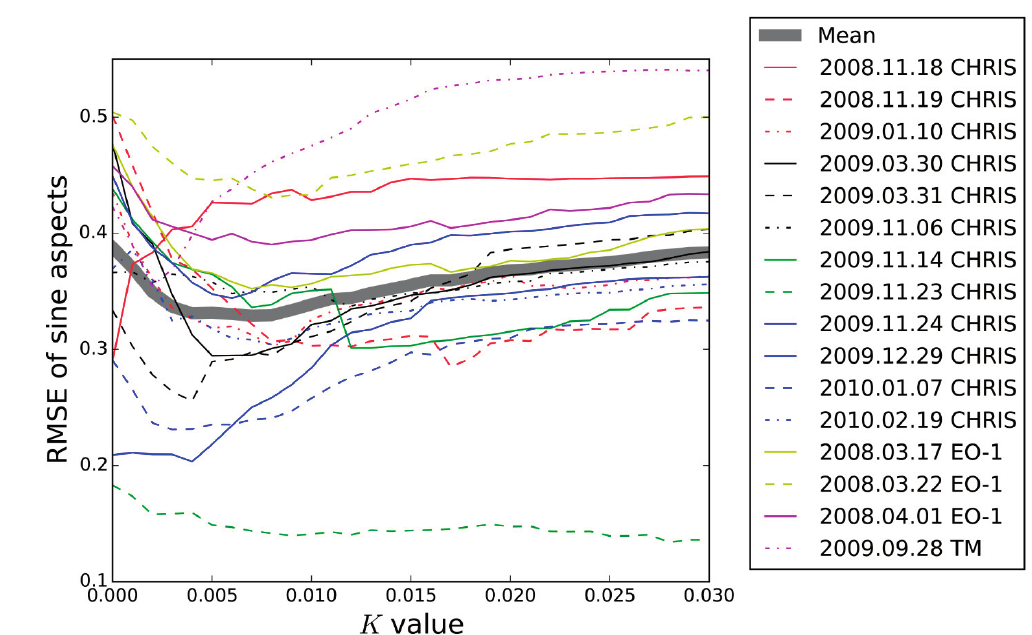
Figure 7. RMSE between the sine of the aspects of the downscaled snow covered subgrids and real snow covered